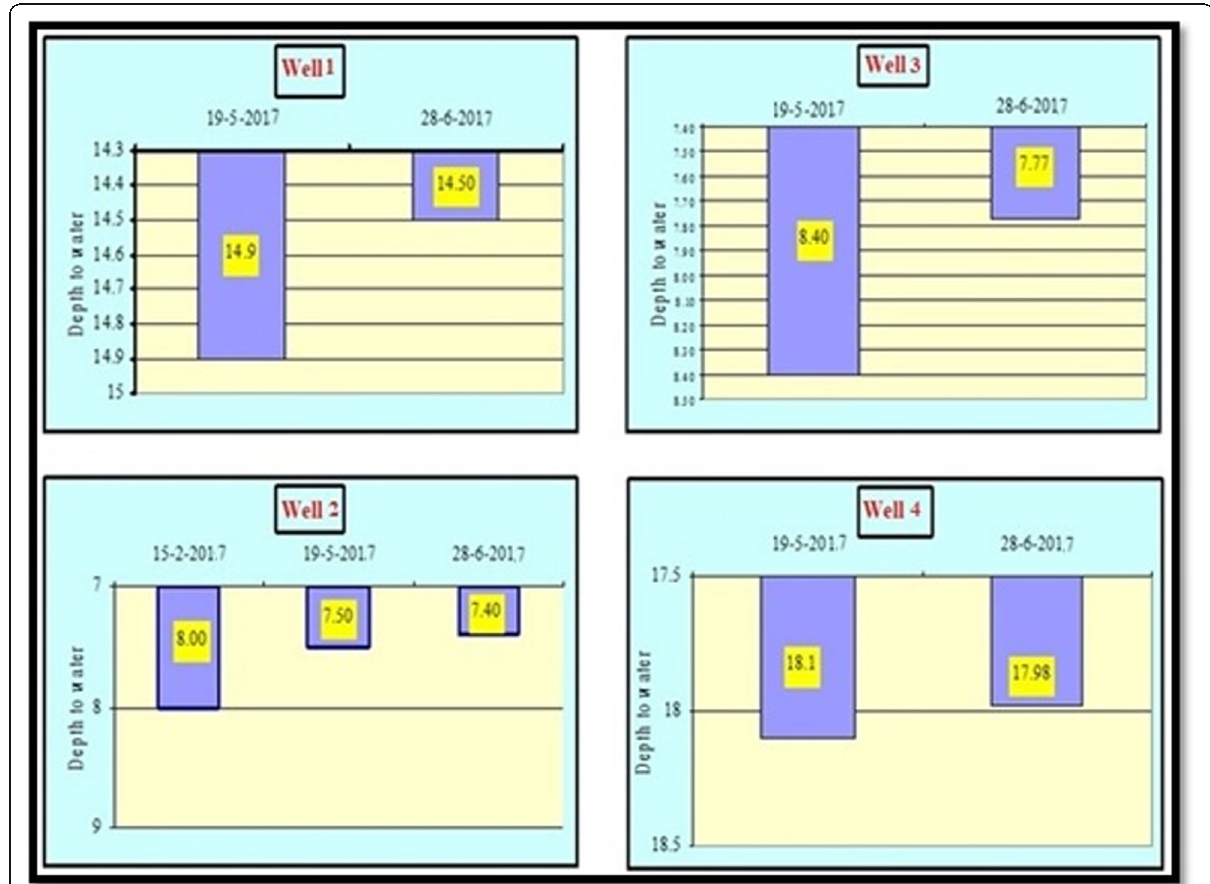
Fig. 7 Changes in the groundwater depth in some wells with